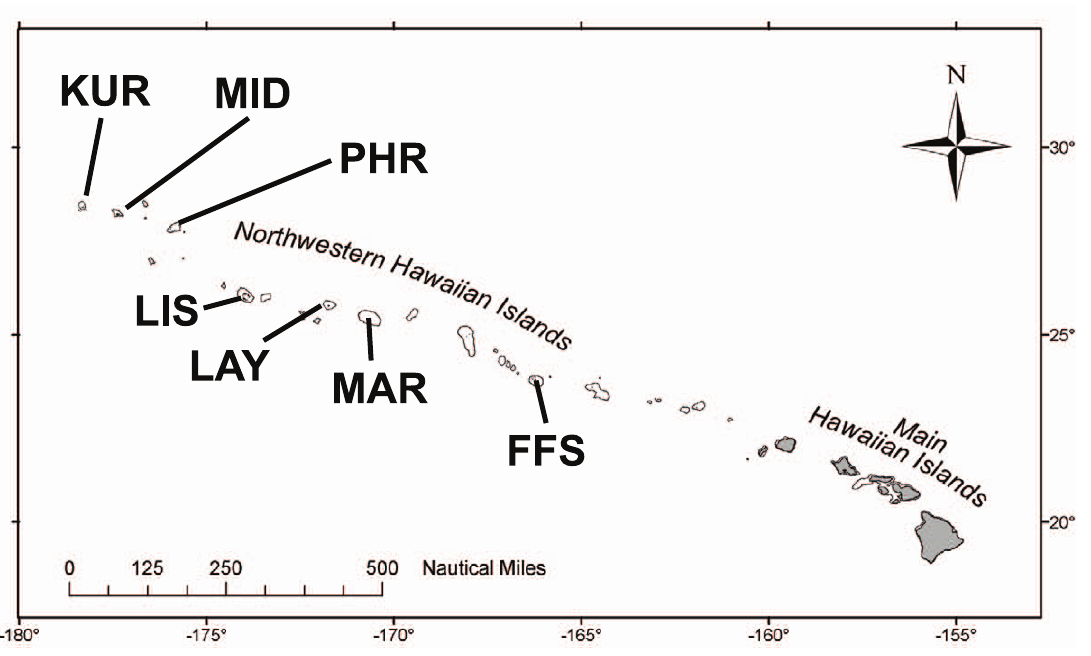
Figure 1. Map of the Northwestern Hawaiian Islands. KUR=Kure Atoll, MID=Midway Atoll, PHR=Pearl and Hermes Atoll, LIS=Lisianski Island, LAY=Laysan Island, MAR=Maro Reef, FFS=French Frigate Shoals.